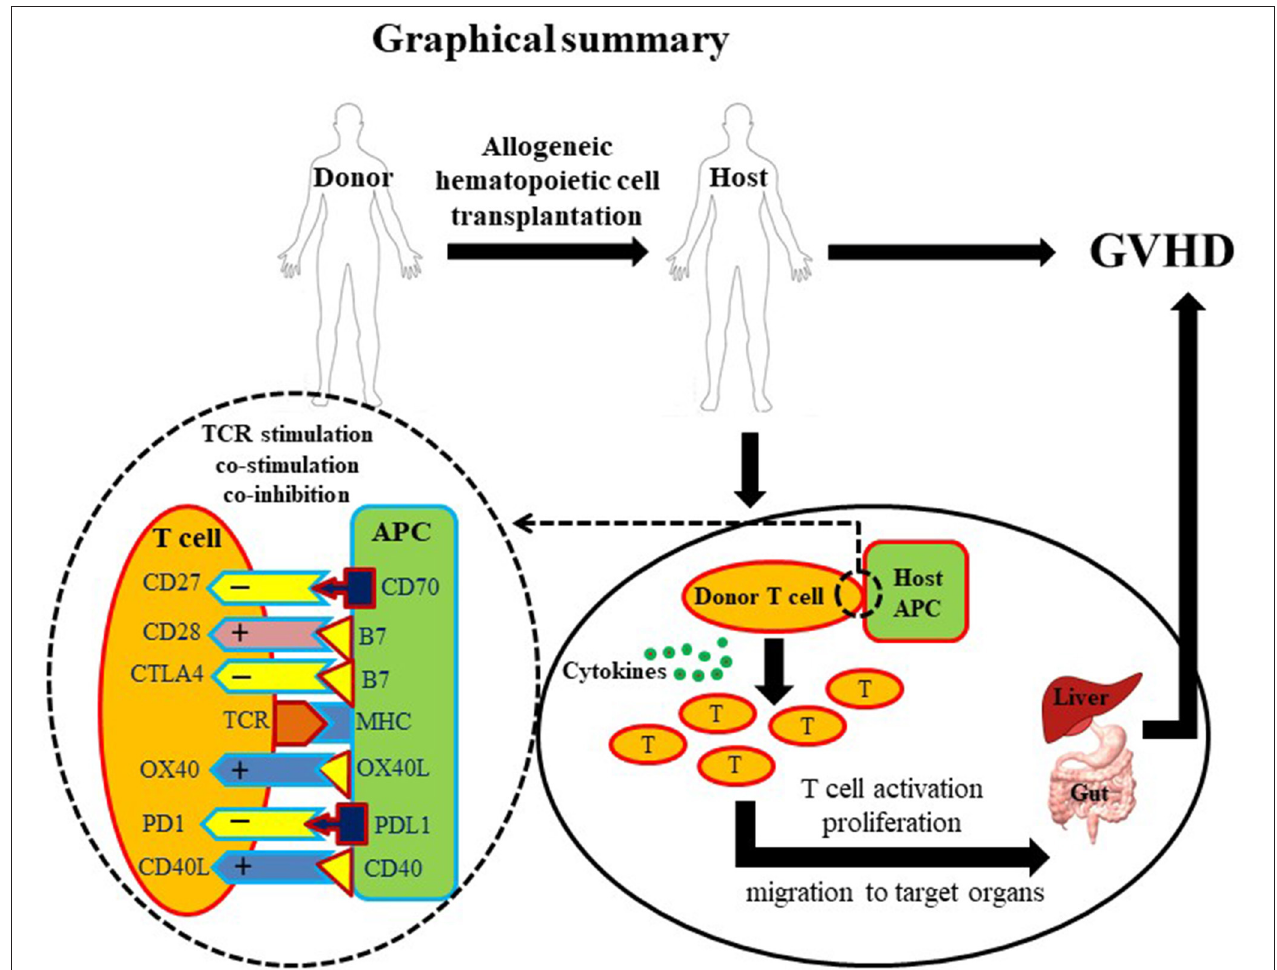
FIGURE 1 | Graphical summary. A diagrammatic illustration of GVHD occurrence post allo-HCT. Briefly, a healthy donor provides hematopoietic cells to a diseased host. Post-transplantation, donor-derived T cells activate, proliferate and migrate to target tissues. T cell activation requires three basic signals: first, T cell receptor/MHC signal; second, co-stimulatory signal; and third, cytokines. Due to the critical role of T cells in GVHD pathogenesis, T cell depletion (TCD) and suppression account for most established therapeutic approaches. However, overall T cell depletion and suppression may give rise to a disease prone host. Co-stimulatory molecules (depicted with + signs) are highly important for optimal activation of T cells. In contrast, co-inhibitory molecules (depicted with – signs) are important to down-regulate T cell activation preventing excessive immune response. Innovative manipulation of co-stimulatory/co-inhibitory signals may represent a more specific approach to control